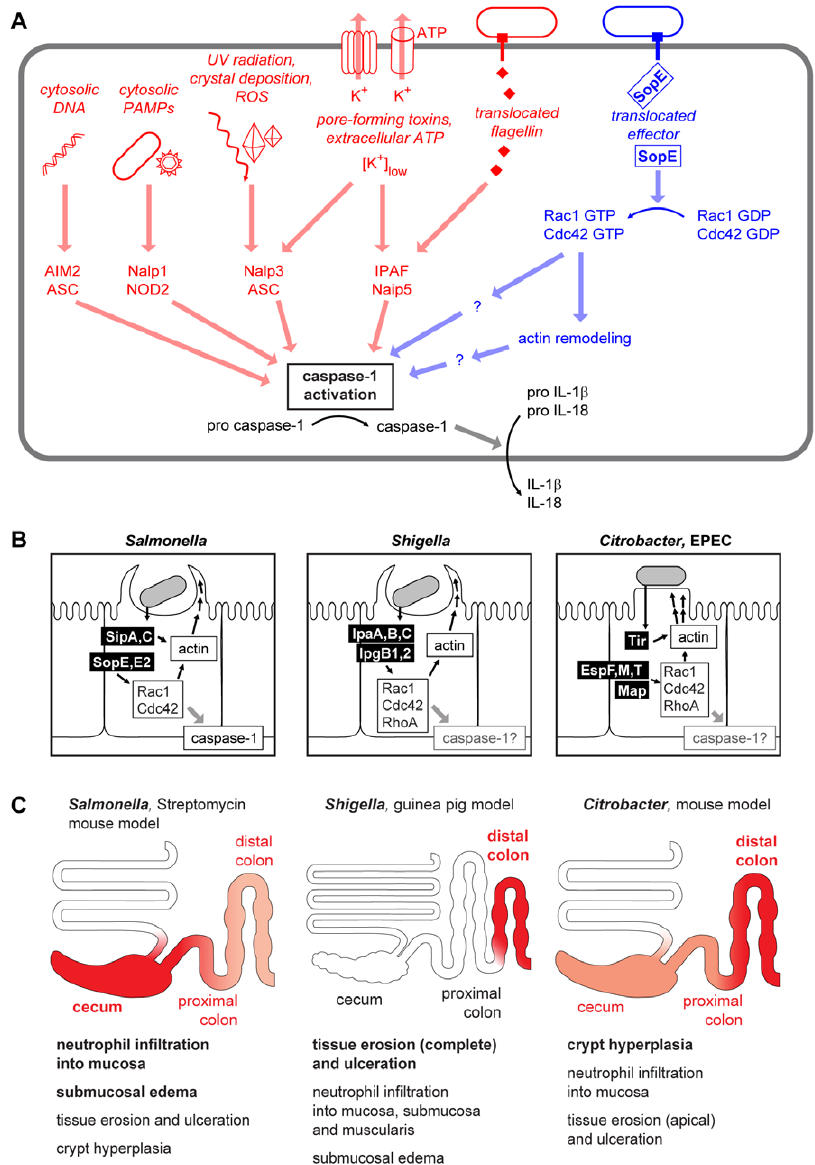
Figure 1. Danger-associated signaling via the inflammasome. (A) Cytosolic microbe- associated molecular patterns and danger signals are detected and integrated by an array of inflammasome components converging at the activation of caspase-1 [5,38–40]. In addition to the already known stimuli for inflammasome activation (left, red), a pathway involving S. Typhimurium SopE and Rho GTPases (right, blue) has been described recently [8]. (B) Comparison of the virulence mechanisms of Salmonella spp., Shigella spp., and Citrobacter /EPEC. The effector proteins injected can act both directly on the actin polymerization as well as via the activation of Rho GTPases [41–43]. (C) Comparison of pathologies in different animal models of Salmonella , Shigella , and Citrobacter /EPEC infection. The region of the strongest pathology and the most important pathological changes in each model is indicated in red. Representative images for the macroscopic and histological changes in the respective animal models can be found in references